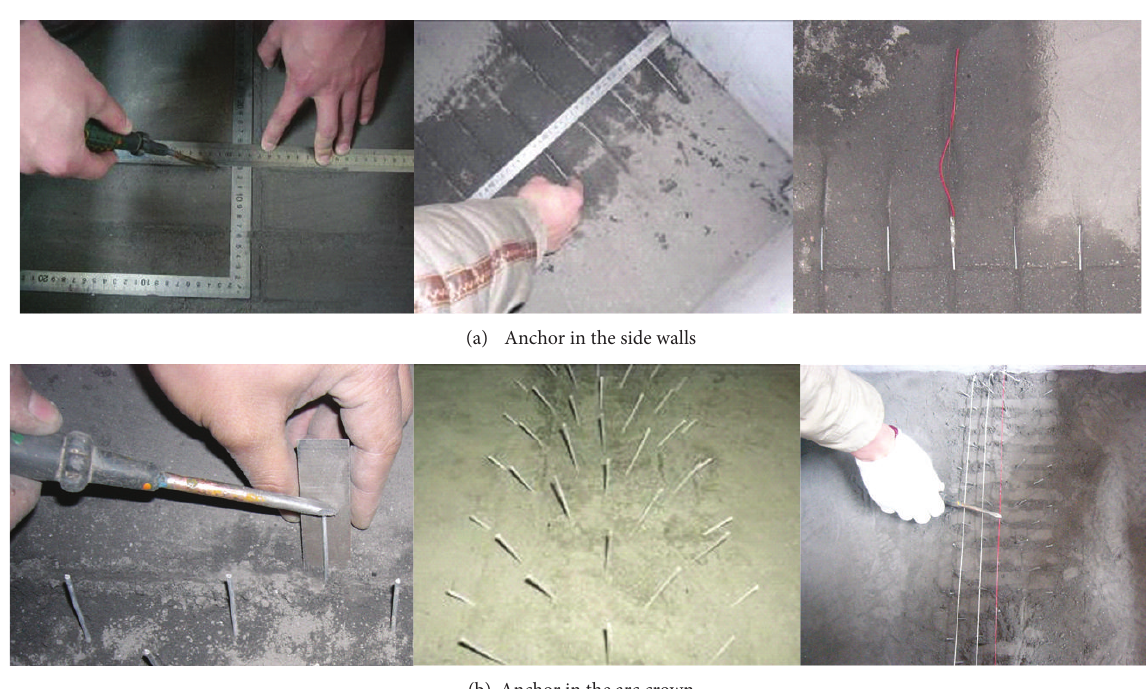
Figure 12: Burying procedure of analogical anchor.